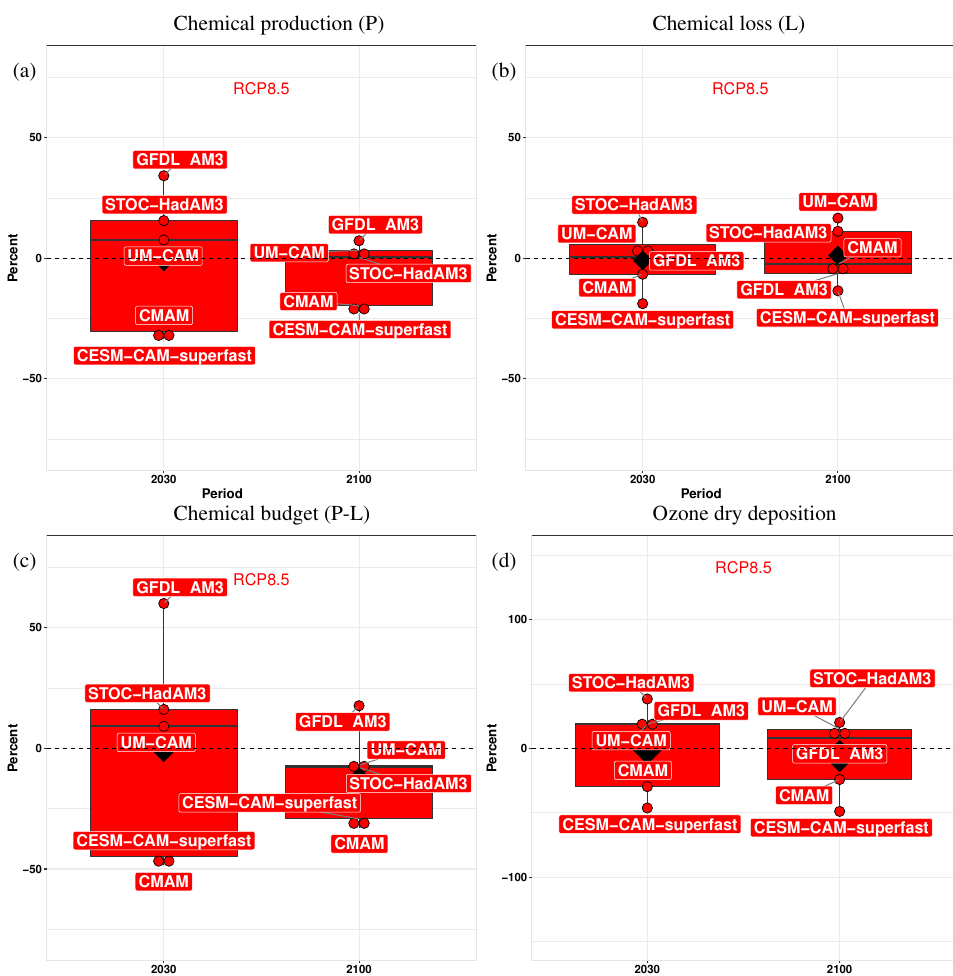
Figure 12. Future relative change in surface ozone budget over the MB domain, (a) chemical production (P), (b) chemical loss (L) and (c) chemical budget (P-L) of surface ozone, (d) dry deposition of ozone (D) calculated over the Mediterranean Basin for JJA period and for the RCP8.5. The median is indicated by the thick horizontal black line, the multimodel mean by a filled diamond, the (25–75%) range by the colored box and minimum/maximum excluding outliers by the whisker. Each point represents a single model. The dashed horizontal line represents the mean for the REF period (2000) and is considered as a reference. The future relative change was calculated over the periods 2027-2040 and 2085-2110 (see Table 3).